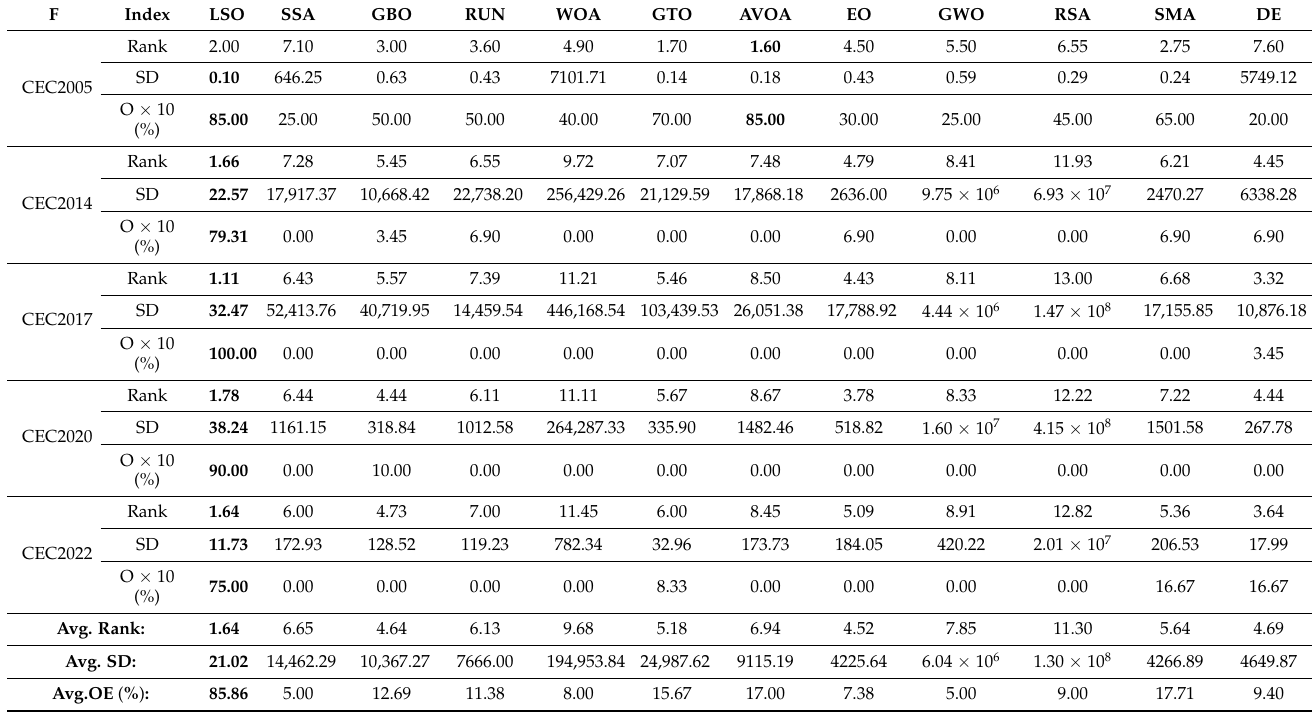
Table 16. Overall effectiveness over five investigated benchmarks (The bolded and red value is the best overall).